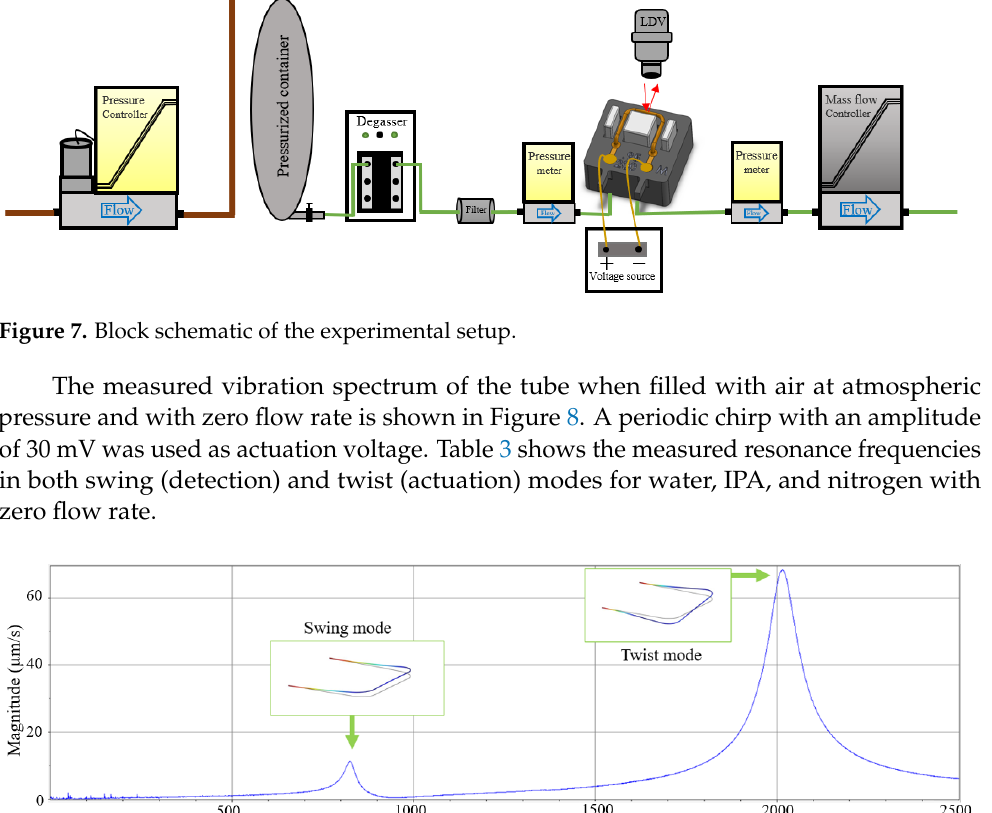
Figure 6. Photographs of the 3D-printed Coriolis mass flow sensor: ( a ) top view and ( b ) bottom view.